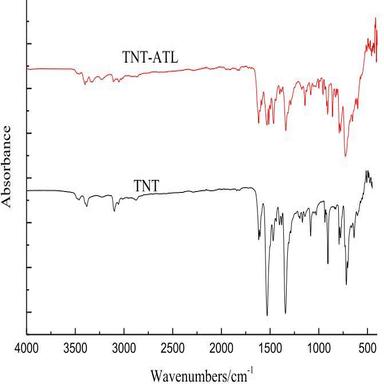
Comparison of infrared spectrum patterns for TNT and TNT-ATL.